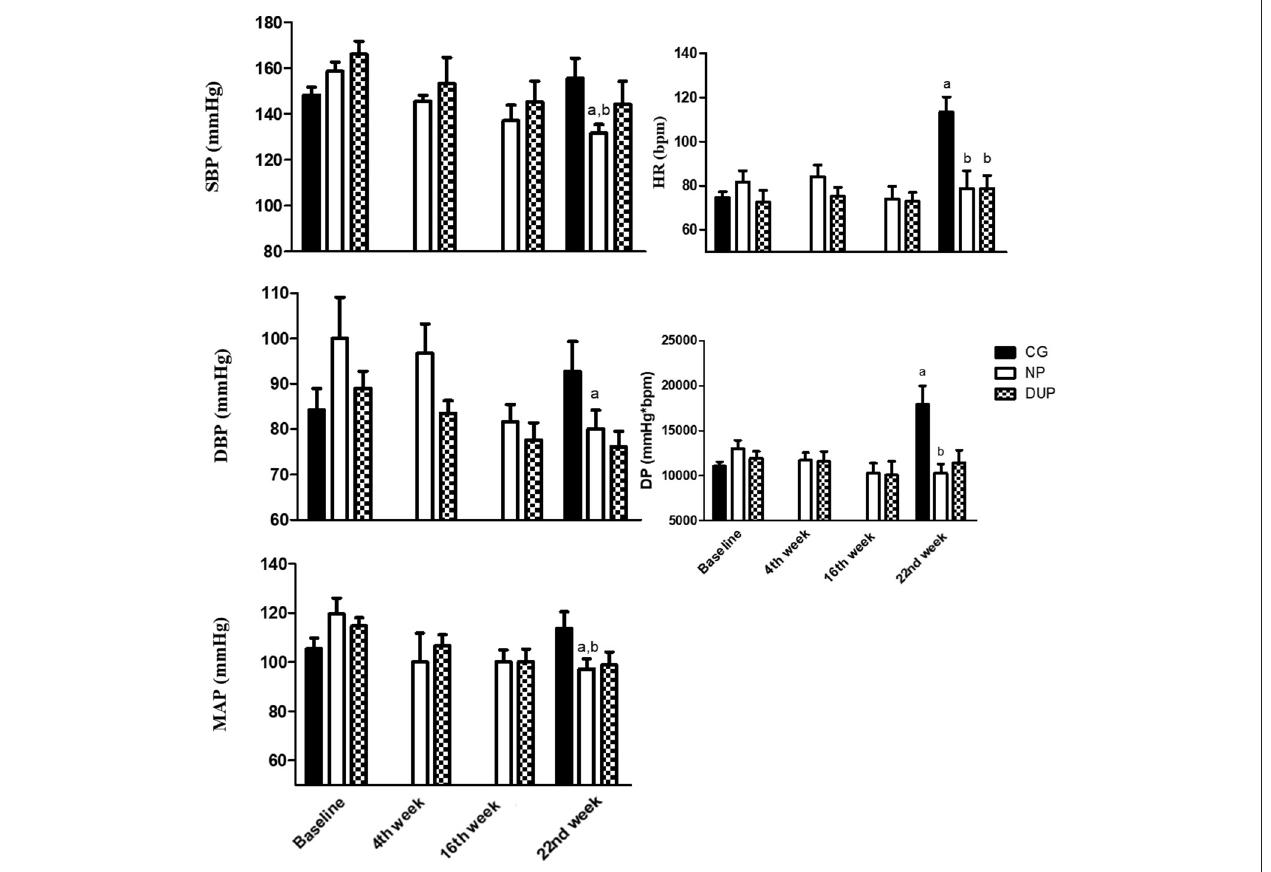
FIGURE 4 | Hemodynamic parameters of experimental groups in the hypertensive subsample. Values expressed as mean ± SD.NP, Non-periodized; DUP, Daily undulating periodization; CG, Control group; SBP, Systolic blood pressure; DBP, Diastolic blood pressure; MAP, Mean arterial pressure; HR, Heart rate; DP, Double product; a P < 0.05 vs. Baseline; b P < 0.05 vs. CG in the 22nd week. An ANOVA [3 × 2, groups × time] was used to examine differences between NP, DUP and CG pre and post-exercise. An ANOVA [2 × 4, groups × time] was used to examine differences between NP and DUP over the 4 measurement moments (Baseline, 4th week, 16th week, and 22nd week). Dunnet was performed as the post-hoc